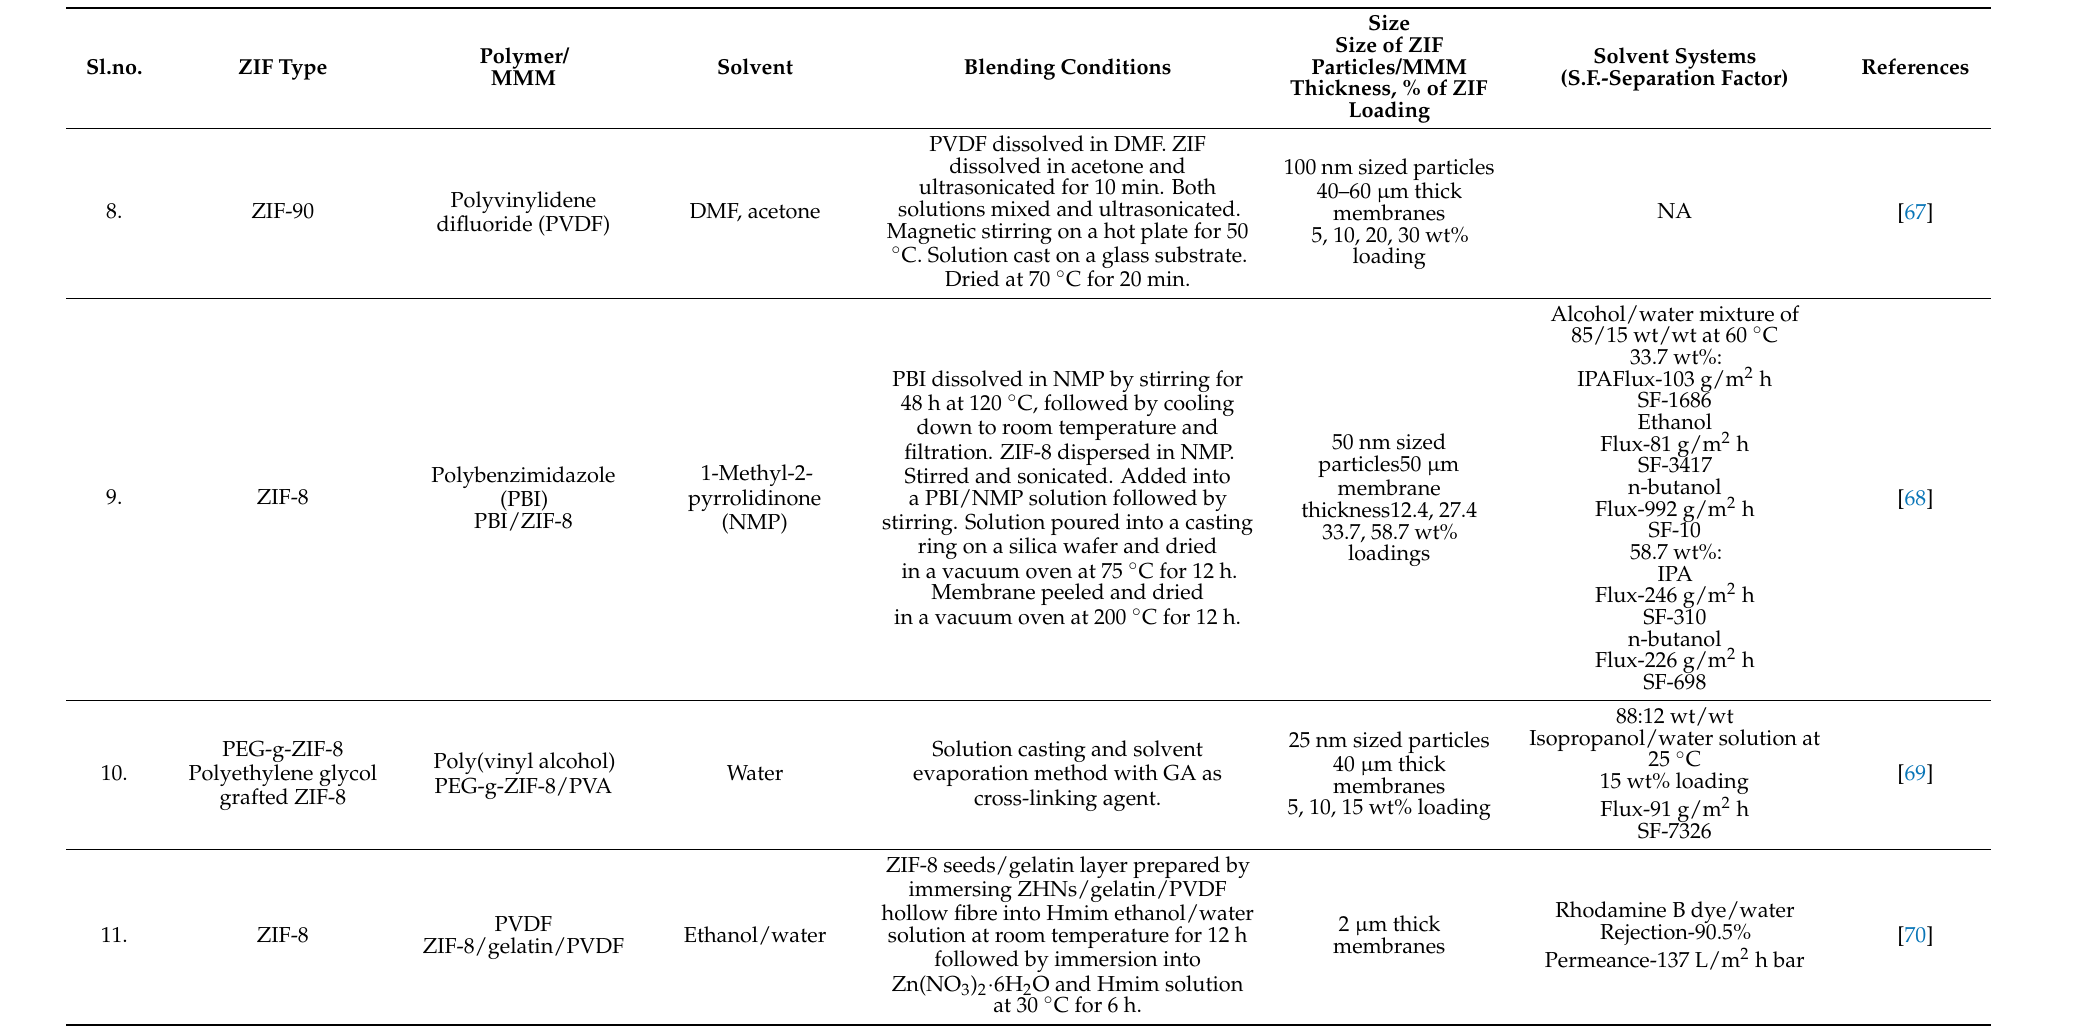
PVDF dissolved in DMF. ZIF dissolved in acetone and ultrasonicated for 10 min. Both Polyvinylidene solutions mixed and ultrasonicated. DMF, acetone difluoride (PVDF) Magnetic stirring on a hot plate for 50 ◦ C. Solution cast on a glass substrate. Dried at 70 ◦ C for 20